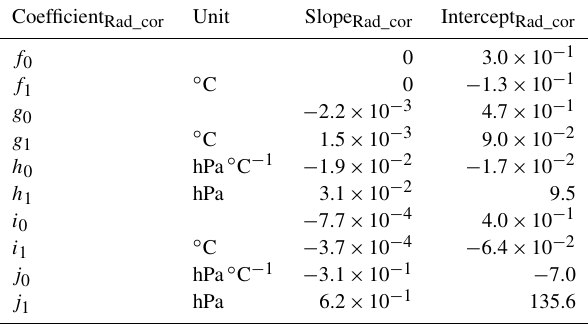
Table 2. Slope Rad_cor and Intercept Rad_cor of f 0 , f 1 , g 0 , g 1 , h 0 , h 1 , i 0 , i 1 , j 0 and j 1